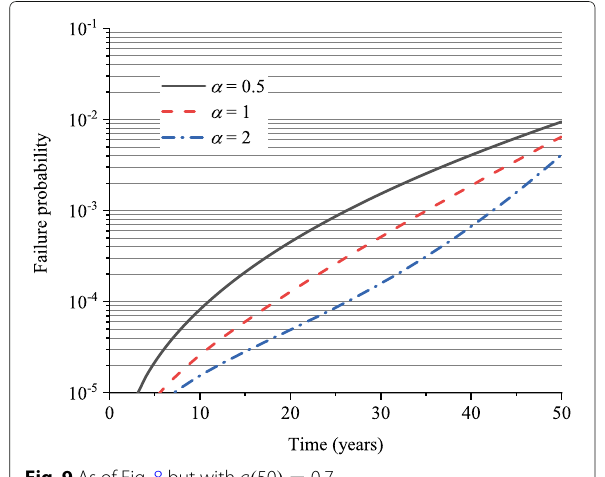
Fig. 7 As of Fig. 6 but with g ( 50 ) = 0.7